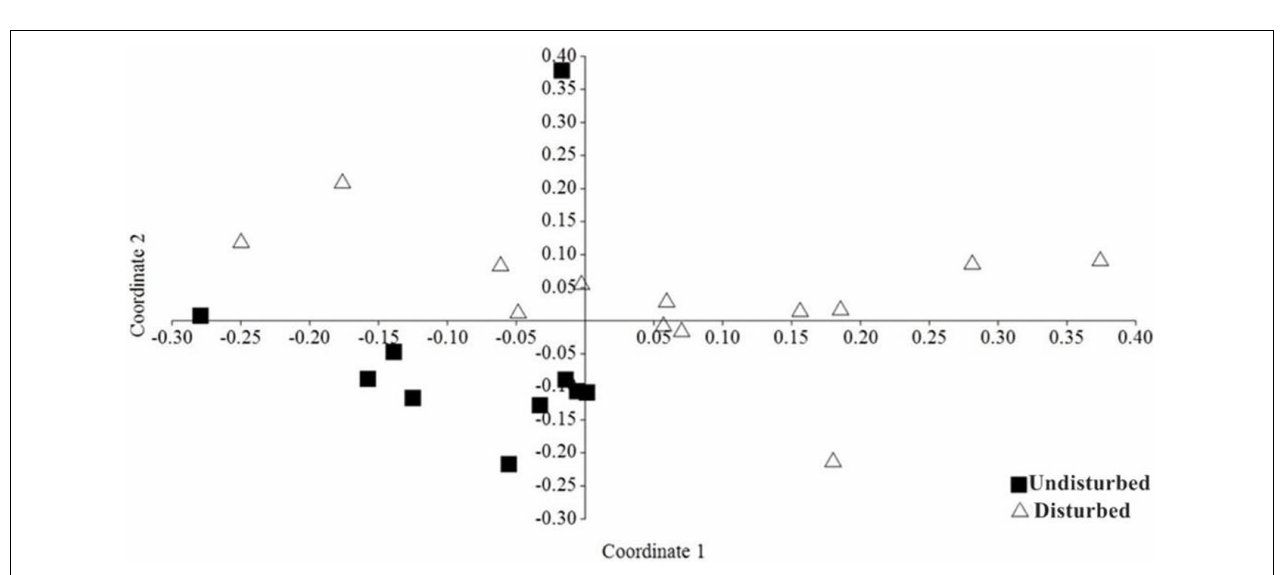
FIGURE 5 | NMDS ordination, showing the difference between undisturbed and disturbed habitat sites of the Afromontane biome of western, Cameroon based on the composition and abundance of bat species using the Bray-Curtis index as a measure of similarity (Stress = 0.23).